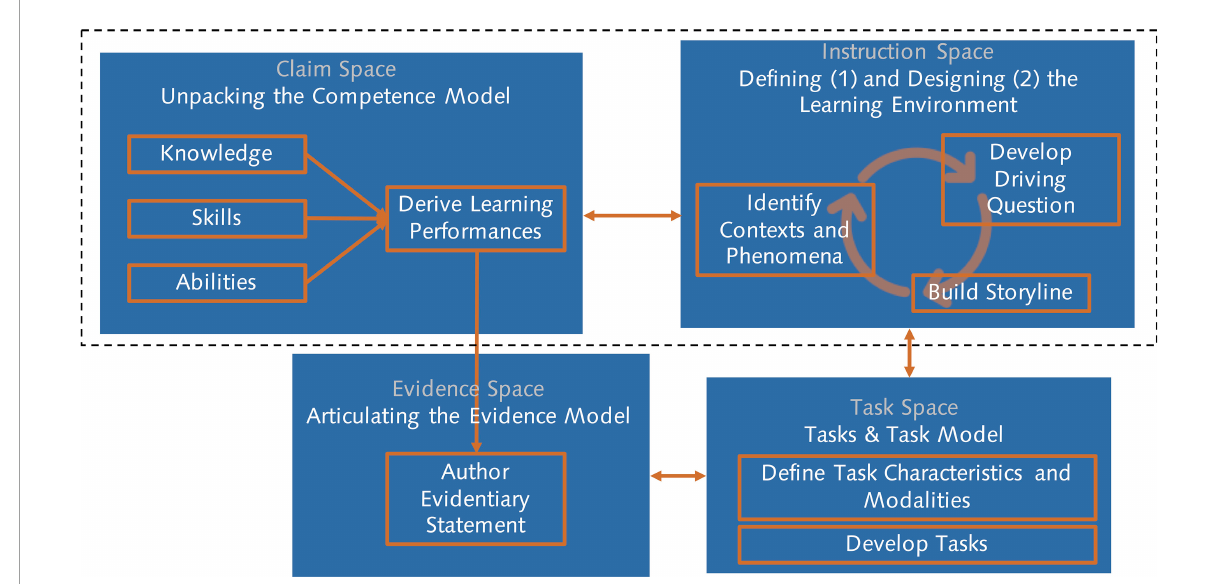
FIGURE4 A procedure for developing digital learning environments that allow for the automated assessment of learning.